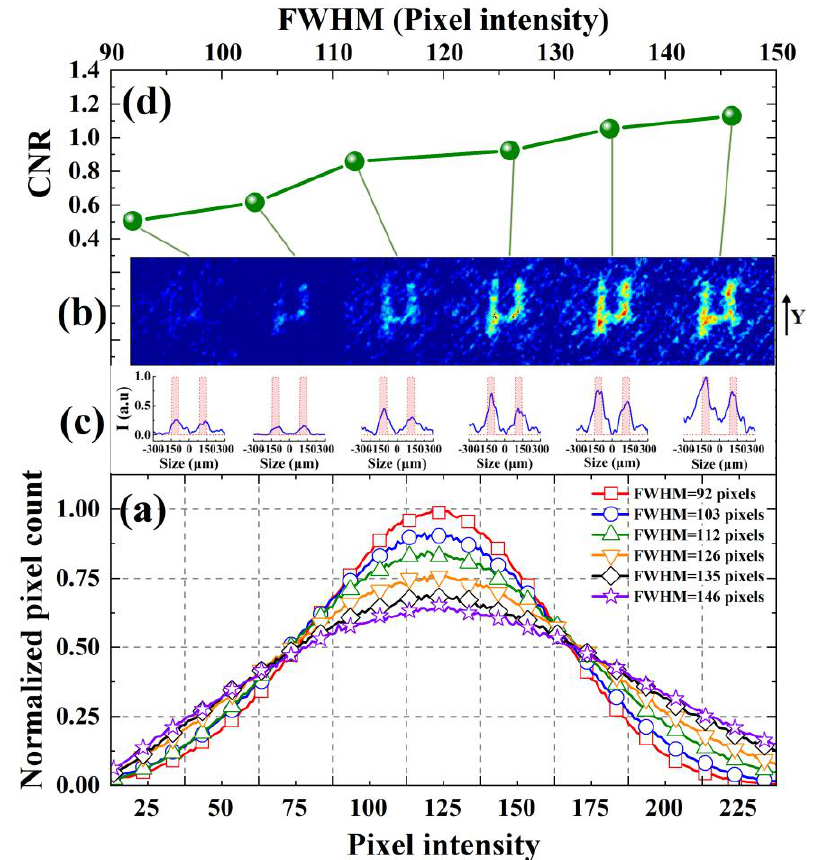
Figure 2. The evolution of the contrast-to-noise ratio (CNR) and reconstruction of the object image. ( a ) The measured speckles’ pixel intensity distribution with different full widths at half maximum (FWHMs). Only one symbol is displayed for every 10 data. ( b ) The retrieved images of the letter “ µ ” in different FWHMs of the speckles’ pixel intensity distributions. ( c ) Solid blue lines are the horizontal line-outs of the normalized data of the retrieved ghost images and red dashed curves display the object. ( d ) The CNR as a function of the FWHM of the speckles’ pixel intensity distribution from the nonuniform pseudothermal light.